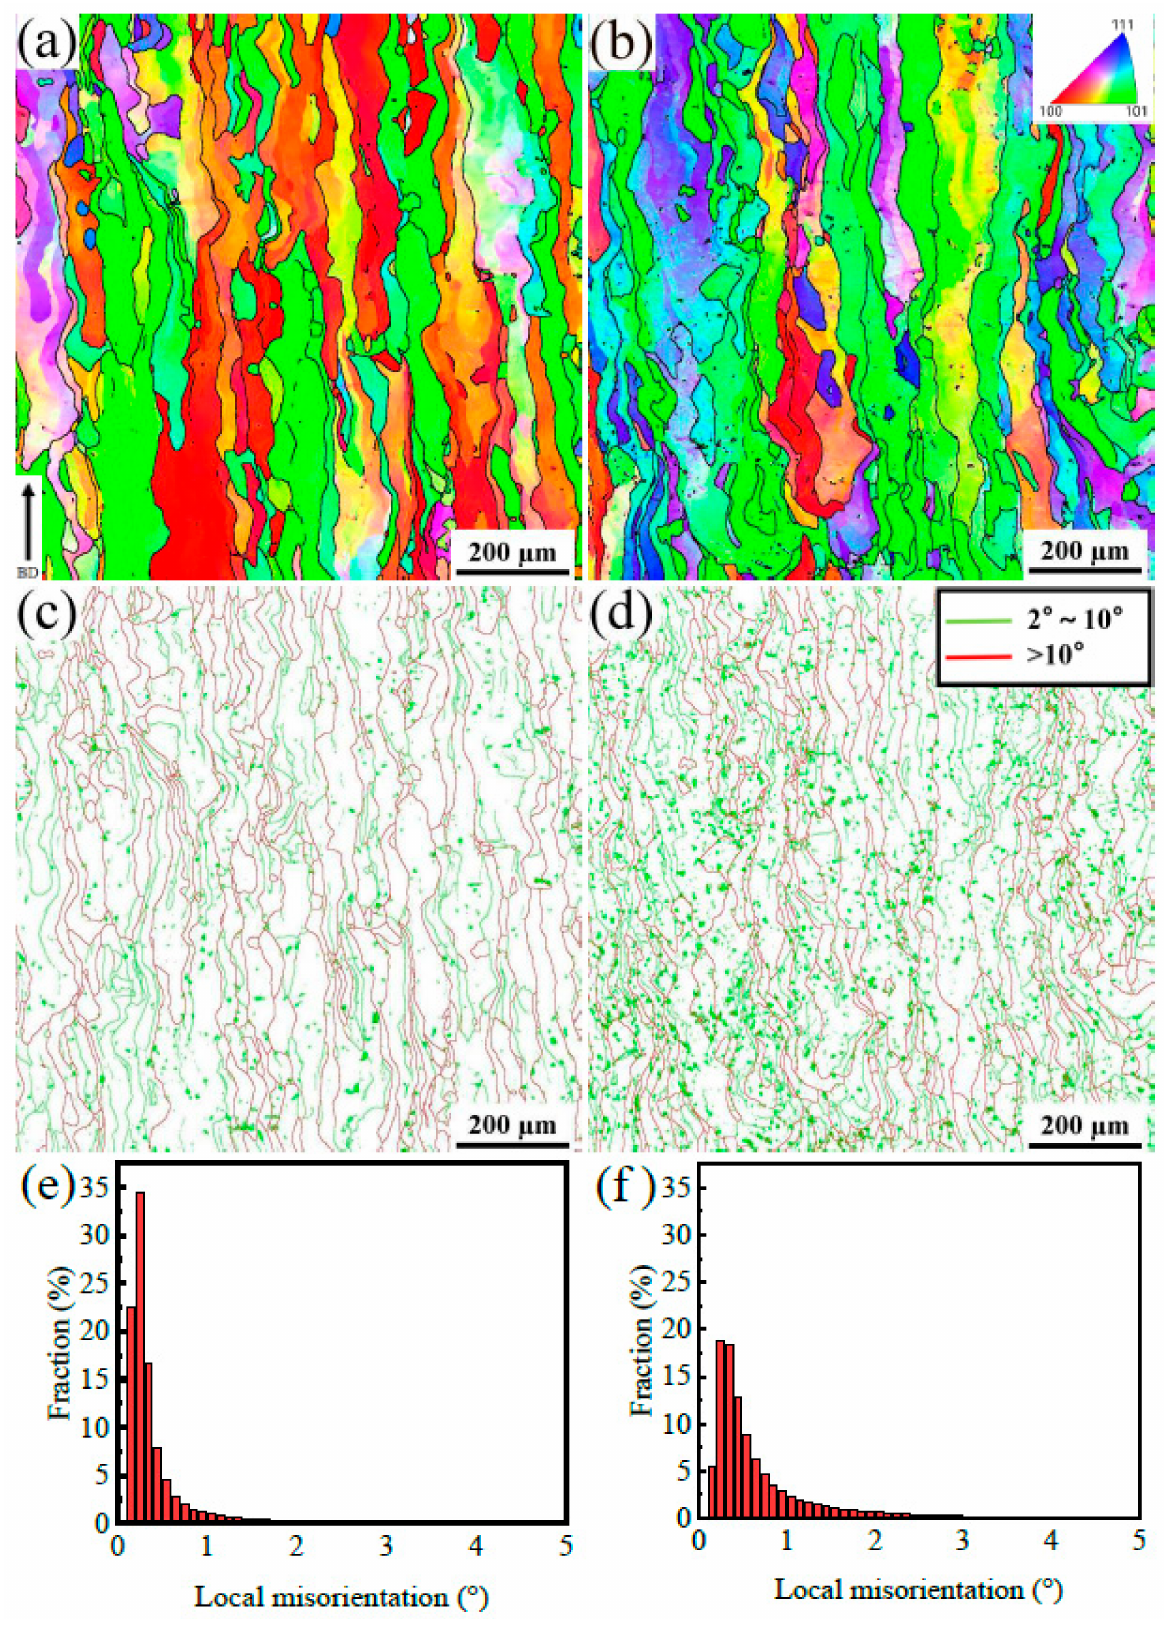
Figure 5. The EBSD results along the building direction showing the grain morphology, grain boundary and local misorientation distribution of SLMed Ta manufactured at different energy densities of ( a , c , e ) 342 J/mm 3 and ( b , d , f ) 190 J/mm 3 ,